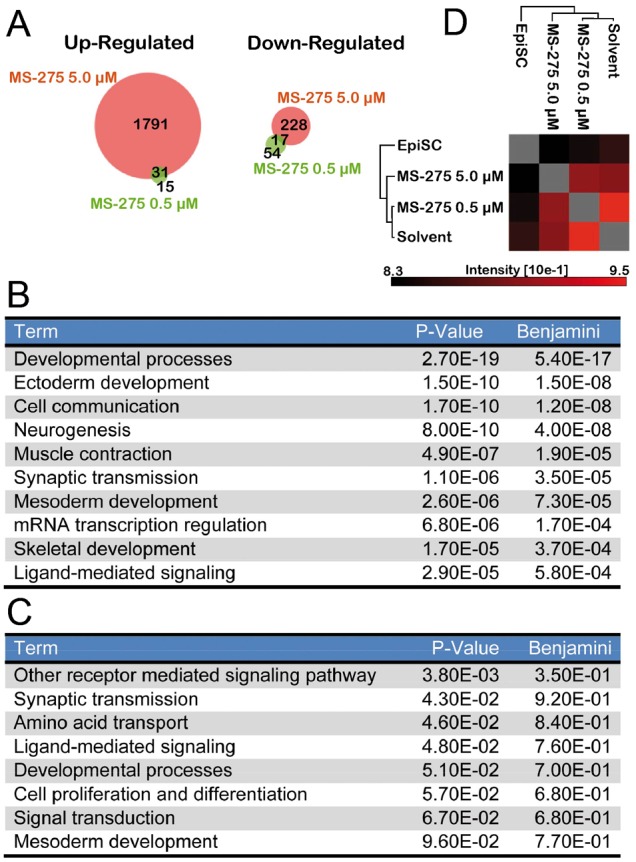
Gene expression profiles suggest neural orientation upon MS-275 treatment.(A) Venn diagram of up- and downregulated genes of 0.5 µM and 5.0 µM MS-275 versus solvent, respectively. (B,C) Gene ontology results for up- and downregulated genes, respectively. (D) Spearman Rank Correlation between MS-275 5.0 µM treated TBV2 and Epi-SCs.